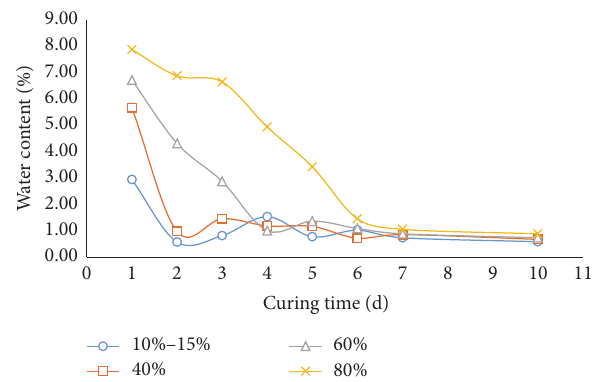
Figure 11: Variation of water content in the gypsum-cemented similar material.